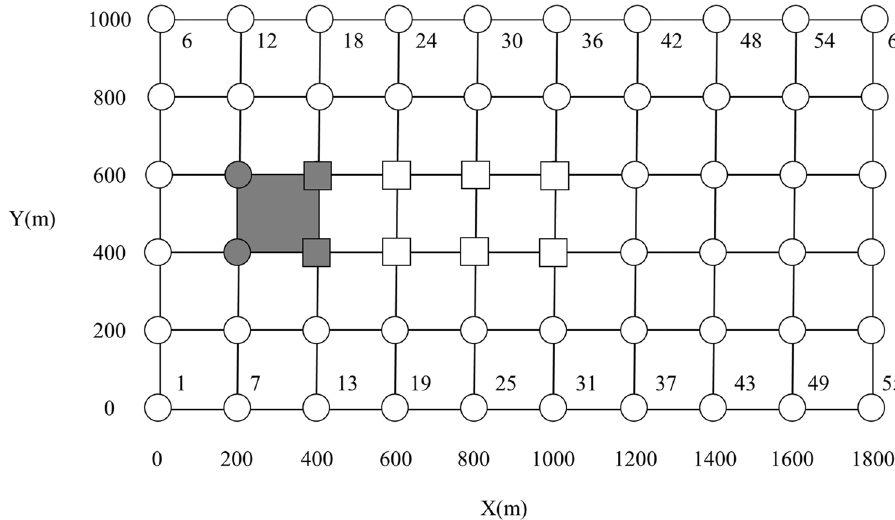
Fig. 2 Finite Element Method Mesh for the hypothetical